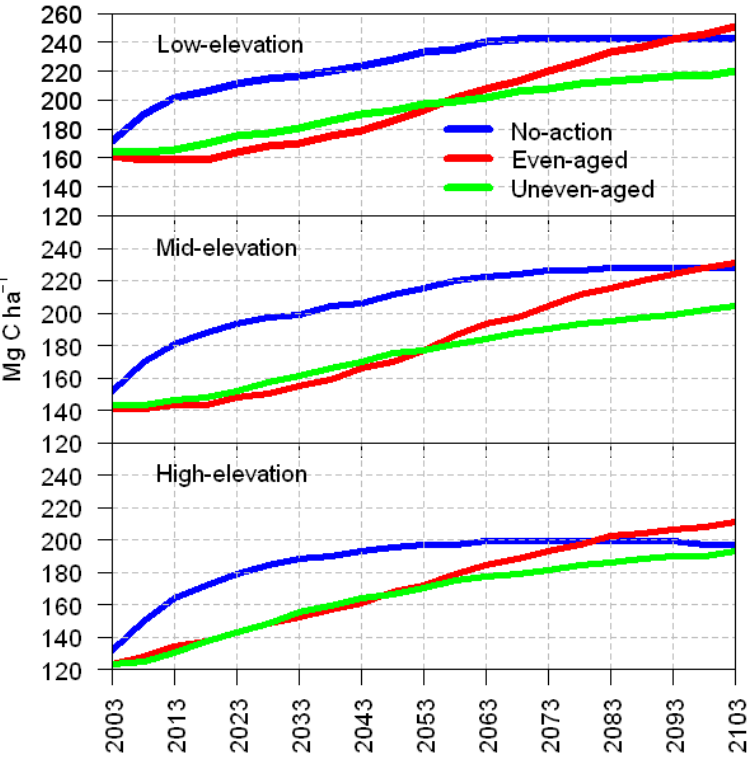
Figure 2. Total aboveground C sequestered (Mg ha − 1 ) for three elevation groups as a result of no-action, even-aged management and uneven-aged management in a southern Appalachian